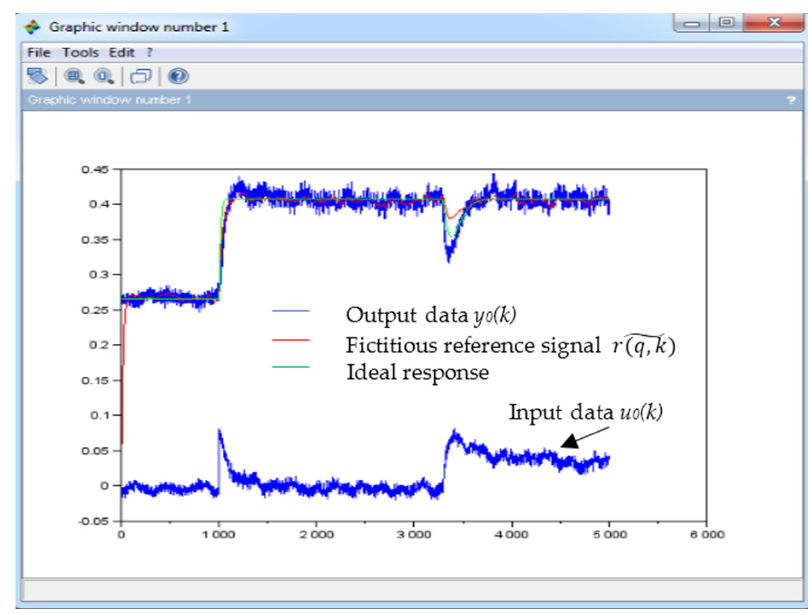
Figure 19. The state of fictitious reference signal r ( q , k ) after 30 iterations.